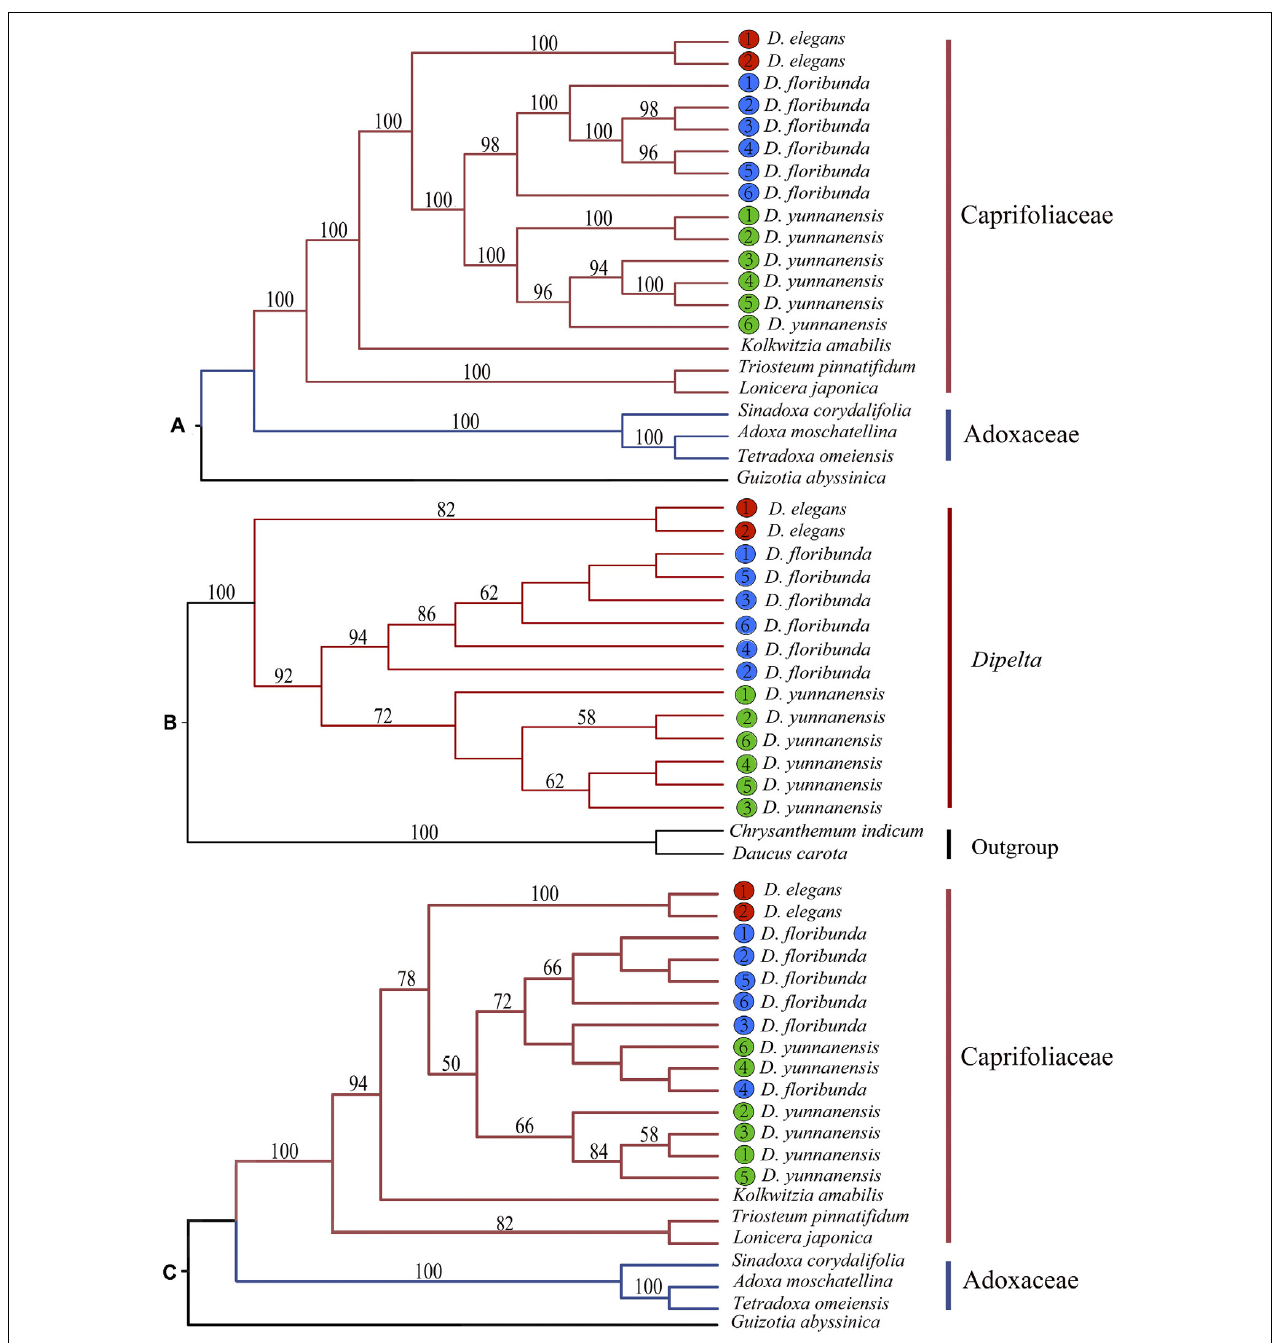
FIGURE 7 | Phylogenetic trees constructed with the complete plastomes (A) , 12 mitochondrial combined genes (B) , and nuclear ITS sequences (C) by using maximum likelihood (ML) analysis. Bootstrap values larger than 50% were labeled above the